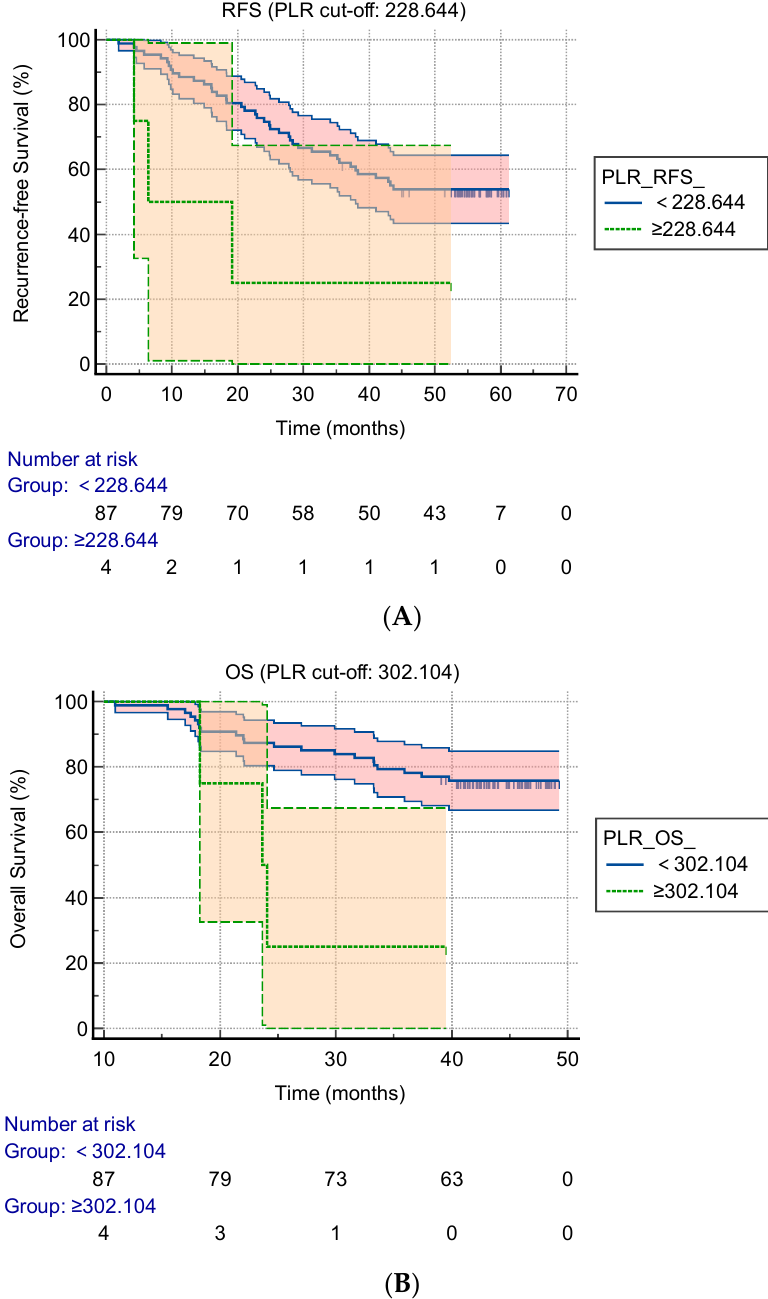
Figure 1. Kaplan – Meier survival plots according to the preoperative PLR. ( A ) Kaplan – Meier analysis of the RFS according to the PLR, with log-rank test (cut-off: 228.644); ( B ) Kaplan – Meier analysis of the OS according to the PLR, with log-rank test (cut-off: 302.104). PLR: platelet-to-lymphocyte ratio, RFS: recurrence-free survival, OS: overall survival.